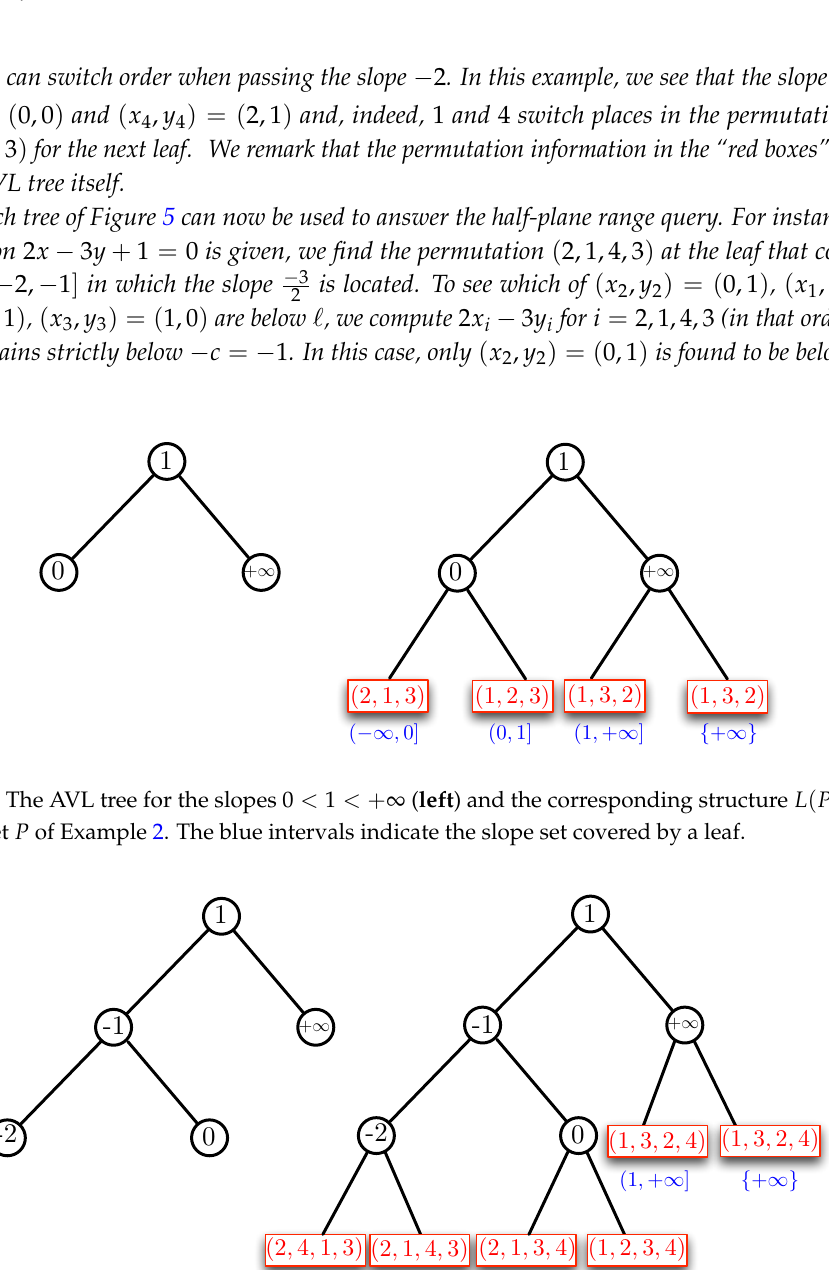
2 < 1 < 0 < 1 < + ∞ ( left ) and the corresponding structure − −